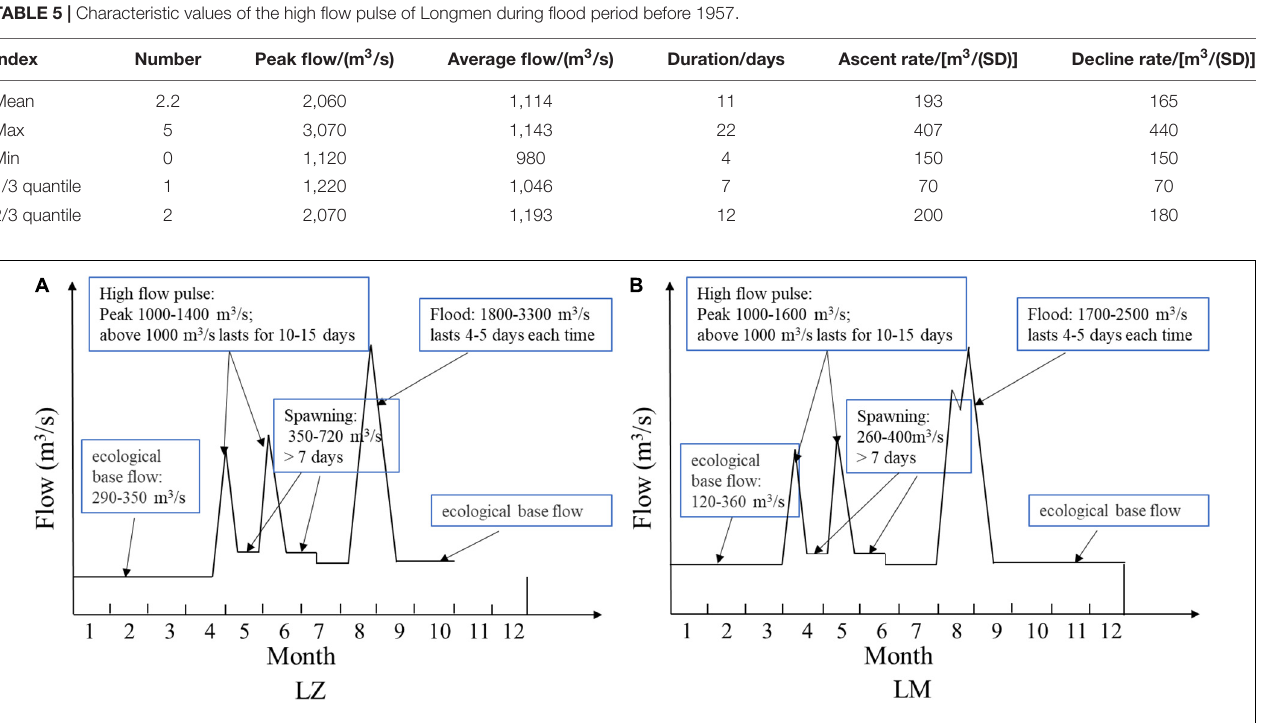
FIGURE 8 | The ecological water requirement process of the key sections of the main stream of the Yellow River. TABLE 6 | The ecological water requirement for main sections of the main stream of the Yellow River. Sections Ecological flow (m 3 /s) Ecological flow in sensitive period (m 3